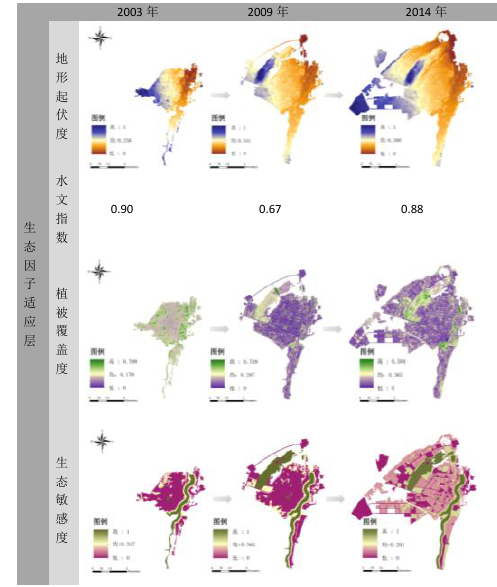
Figure 1. The extraction process of the ecological environment adaptive performance factor in Guyuan City